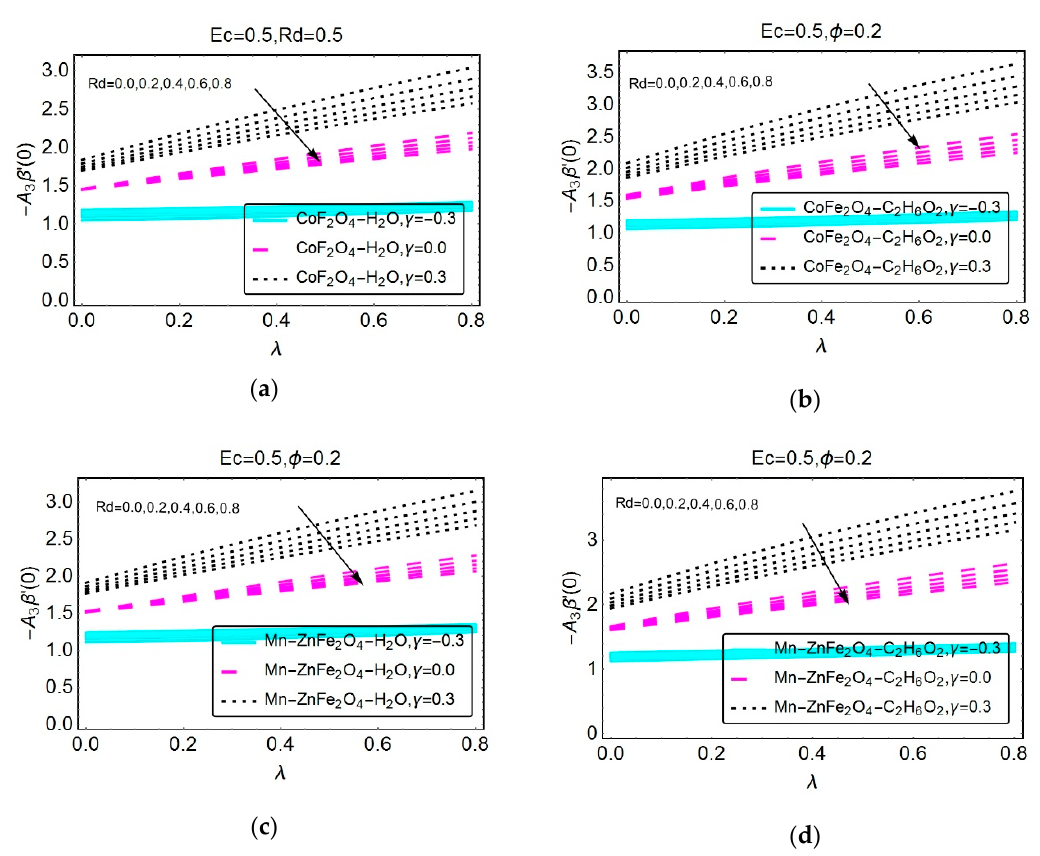
Figure 9. Alterations in the local nusselt number for ( a ) CoFe (cid:2870) O (cid:2872) − H (cid:2870) O ; ( b ) CoFe (cid:2870) O (cid:2872) − C (cid:2870) H (cid:2874) O (cid:2870) ; ( c ) MnZnFe (cid:2870) O (cid:2872) − H (cid:2870) O ; (d) MnZnFe (cid:2870) O (cid:2872) − C (cid:2870) H (cid:2874) O (cid:2870) nanofluids by varying 𝑅𝑑 and 𝜆 .